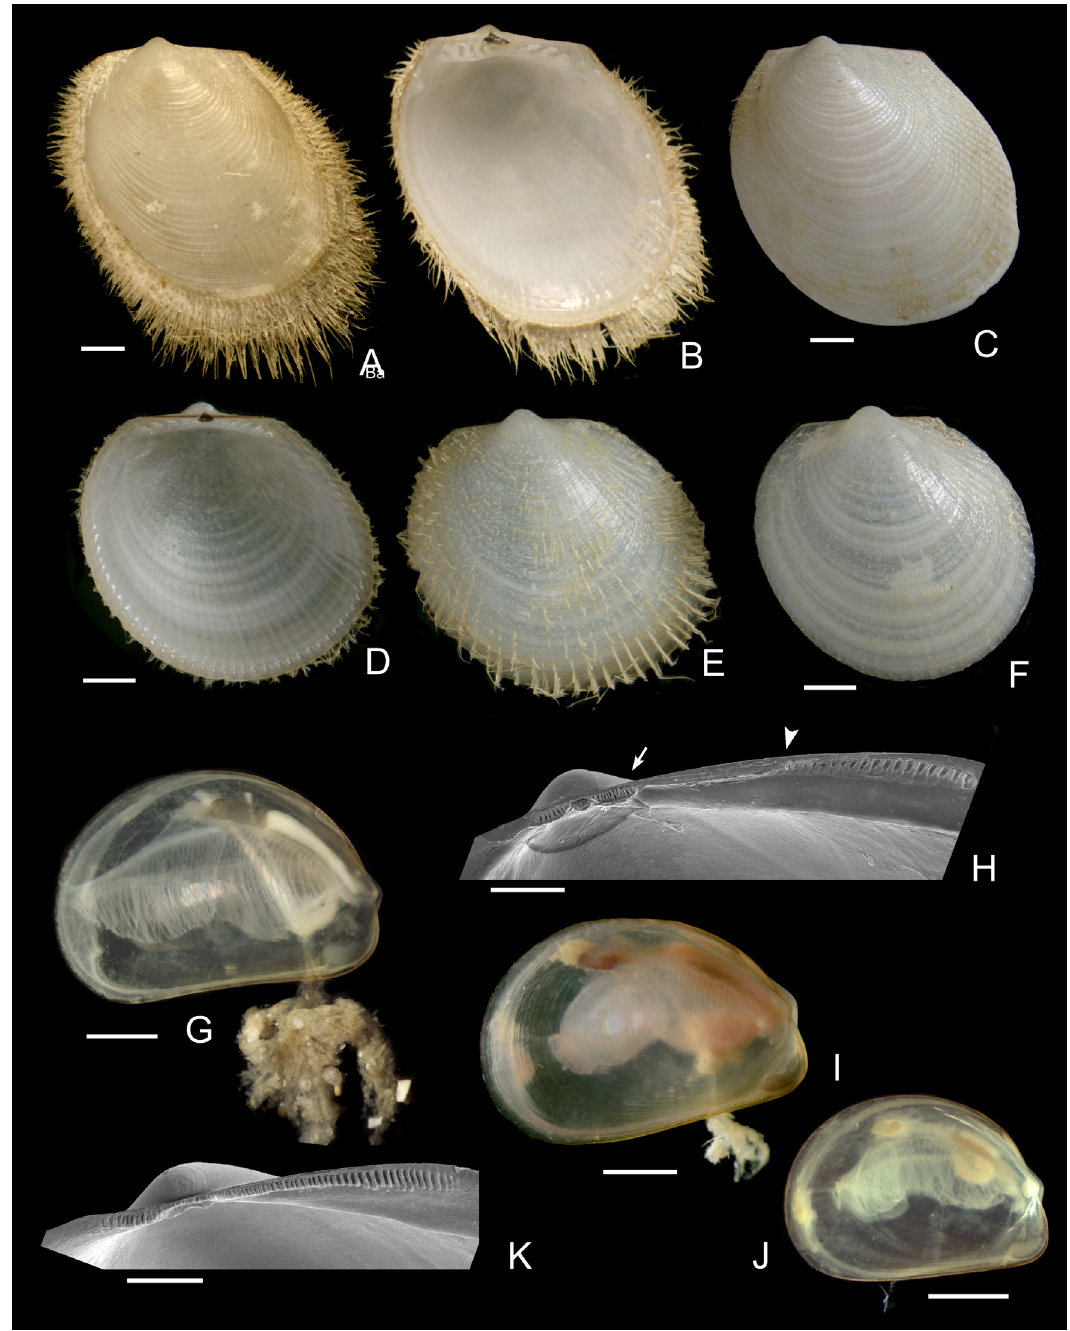
Fig. 34. Limopsidae and Mytilidae. A–B . Limopsis minuta (Philippi, 1836), ECOMARG 0709 V4, 744 m, height 7.8 mm. C . Limopsis minuta , valve without periostracum, same locality, 6.7